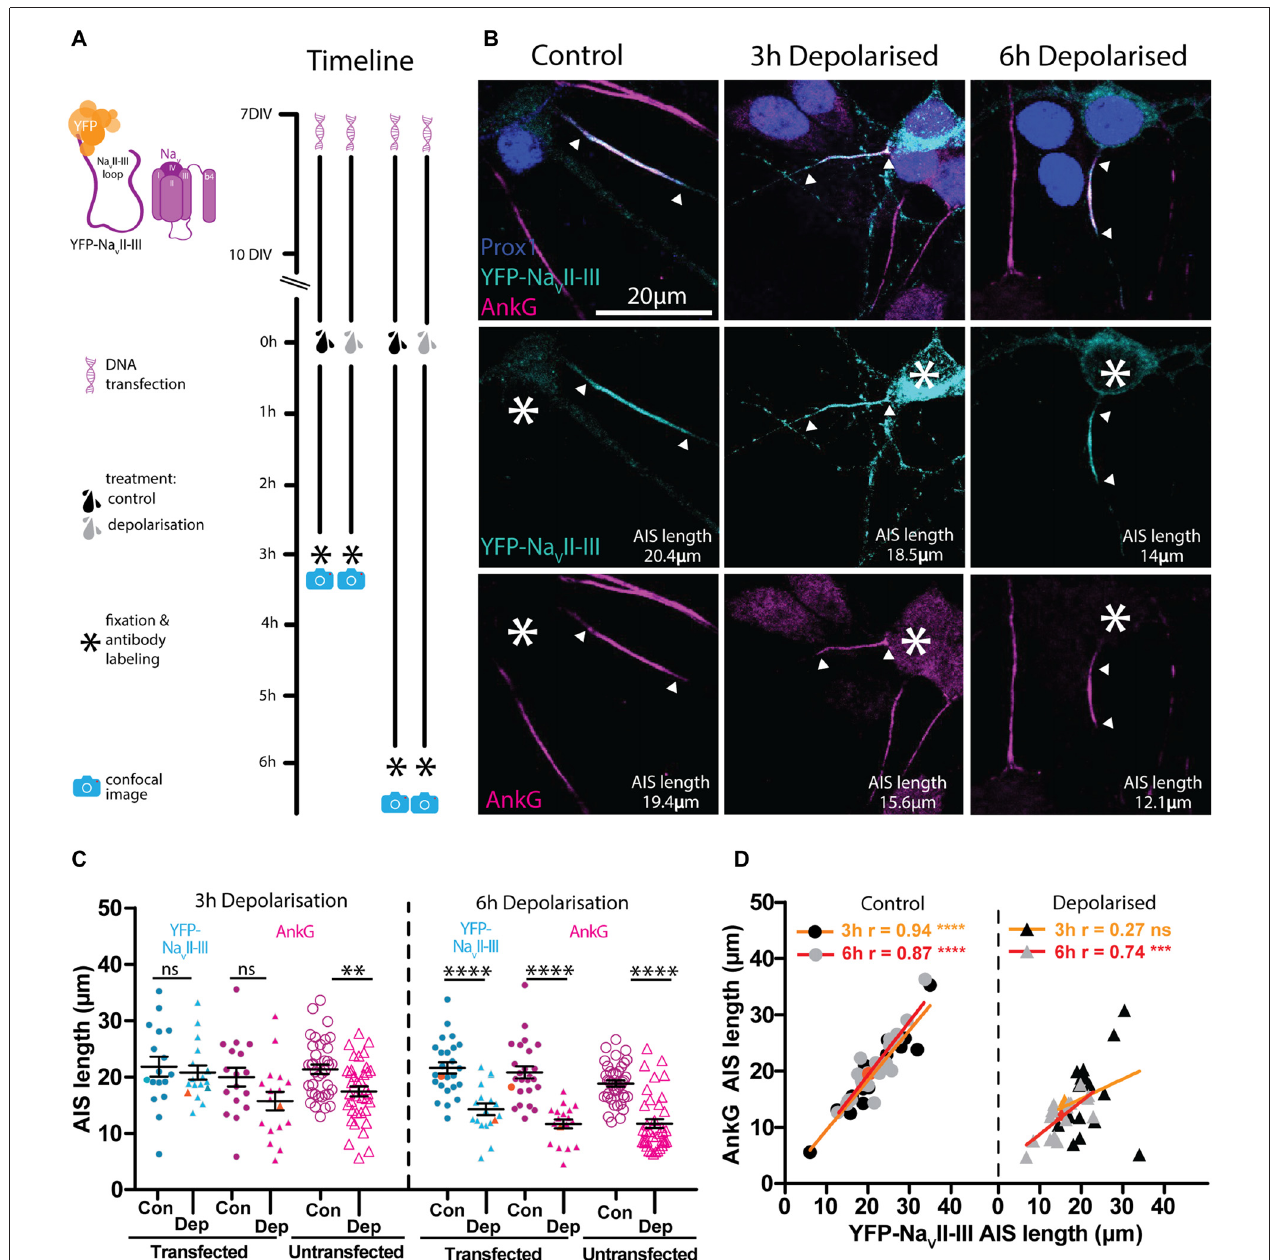
FIGURE 7 | YFP-Na V II–III has a high degree of correlation with AnkG and is able to accurately track AIS plasticity following a 6 h depolarization treatment. (A) Diagram of the experimental timeline used to test the YFP-Na V II–III construct as an AIS live label. (B) Maximum intensity projections of control or 3 h and 6 h depolarized DGCs bearing YFP-Na V II–III live-labeled AISs (cyan) and stained post fixation with antibodies against AnkG (magenta) or prox1 (dark blue). Asterisks, soma; arrowheads, DGC AIS start and end positions. (C) Distributions of AIS lengths determined from YFP-Na V II–III (blue) and AnkG (magenta) from control (Con) or depolarized (Dep) DGCs. Each symbol represents a single cell; black lines show mean ± SEM; orange symbols represent cells from panel (B) ; Bonferroni post-test after two-way repeated measures ANOVA; ns, non-significant; ∗∗ p < 0.01; ∗∗∗∗ p < 0.0001. (D) Correlation analysis for AISs labeled with YFP-Na V II–III and AnkG under control (dotted symbols) or depolarized (triangle symbols) conditions. Lines show best linear regression fit for a 3 h (orange) or 6 h treatment (red); orange symbols represent cells from panel (B) ; Pearson’s correlation; ns, non-significant; ∗∗∗ p < 0.001; ∗∗∗∗ p < 0.0001.